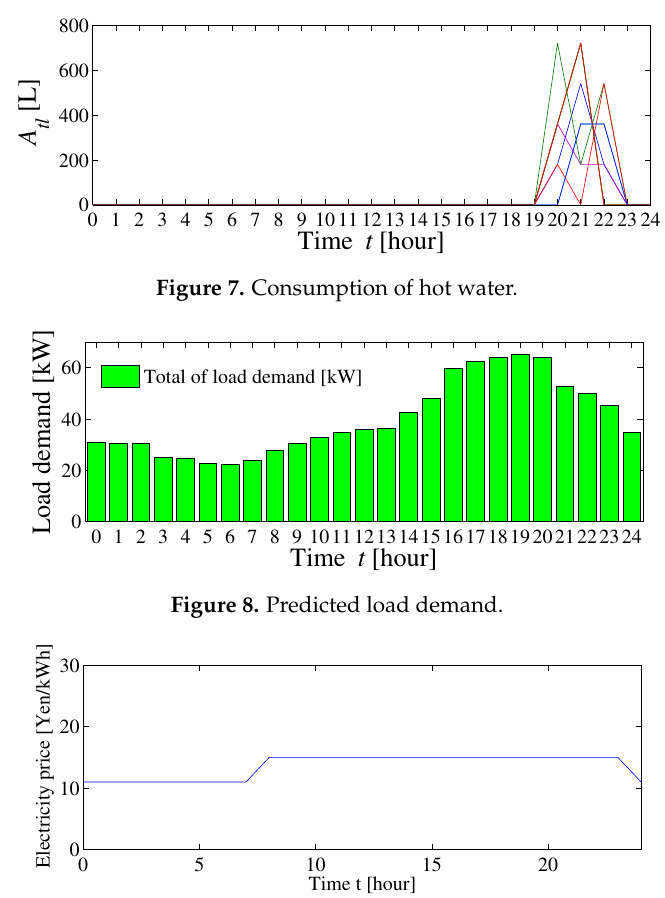
Figure 9. Electricity price for high voltage